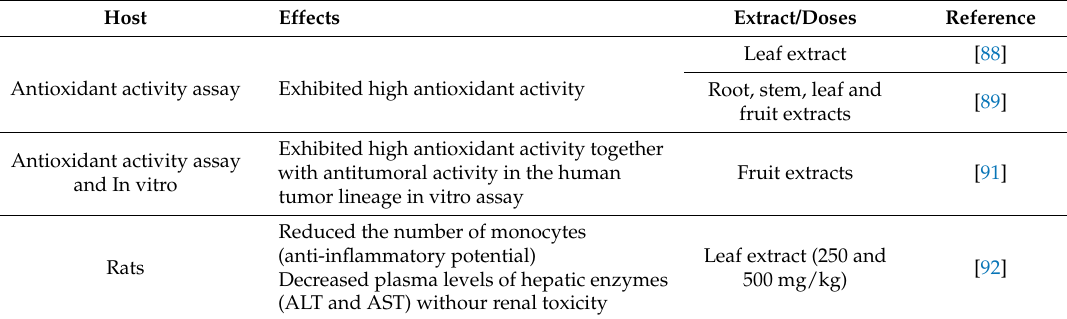
Table 3. Possible effects of C. pubescens in metabolic